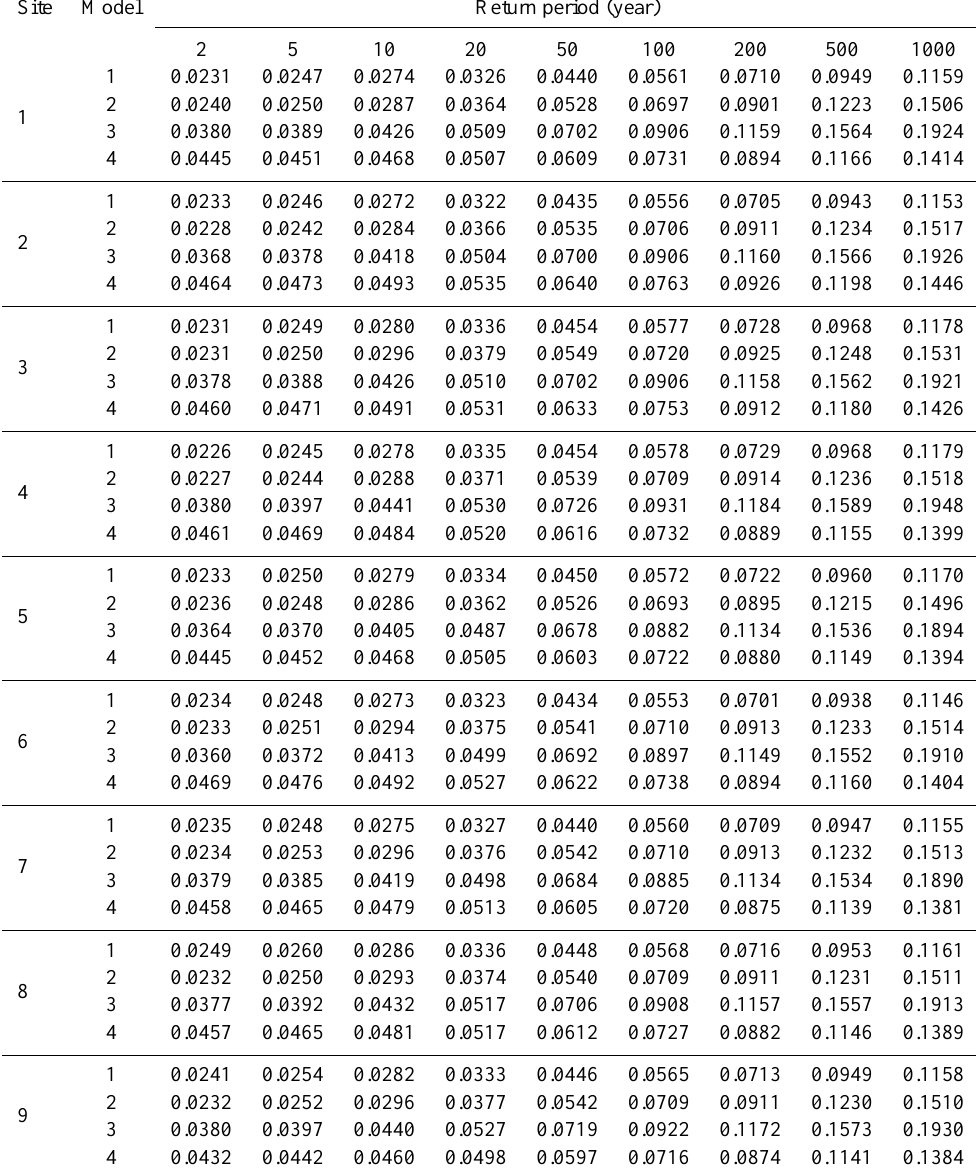
Table 1. RRMSE of 4 NSIFMs for a region with 9 sites (sample size =